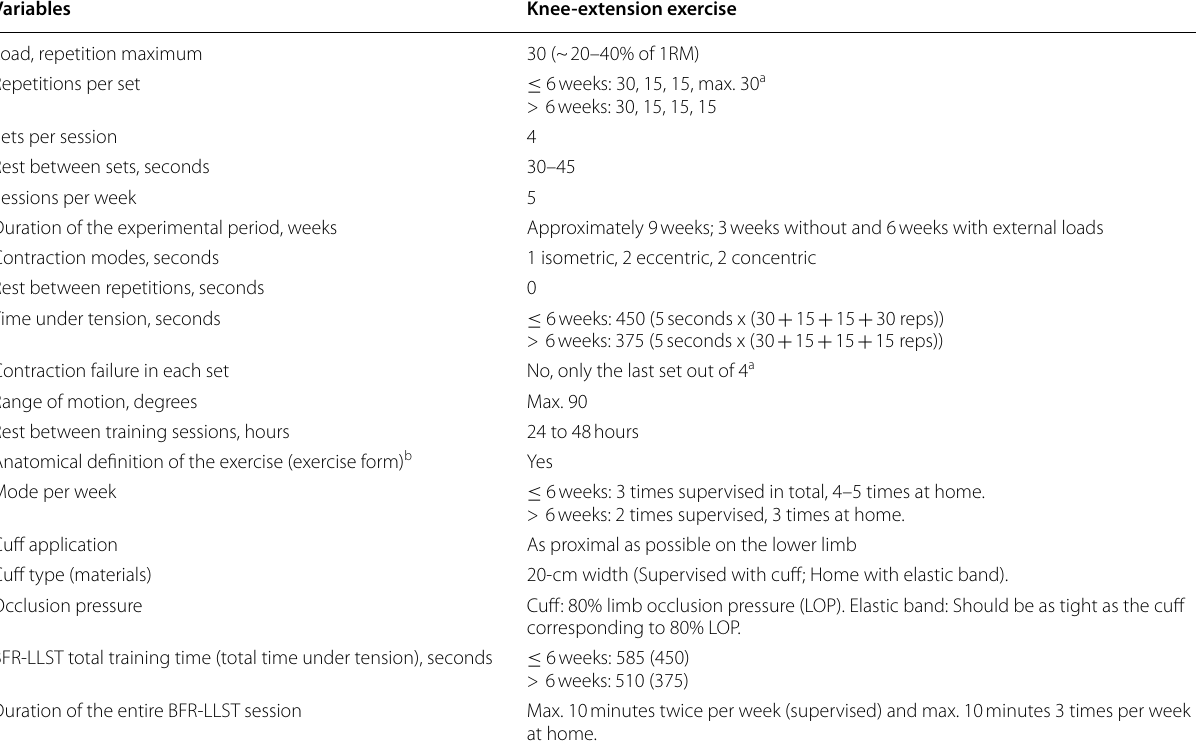
Table 1 The BFR-LLST protocol for the knee-extension exercise [11, 28,